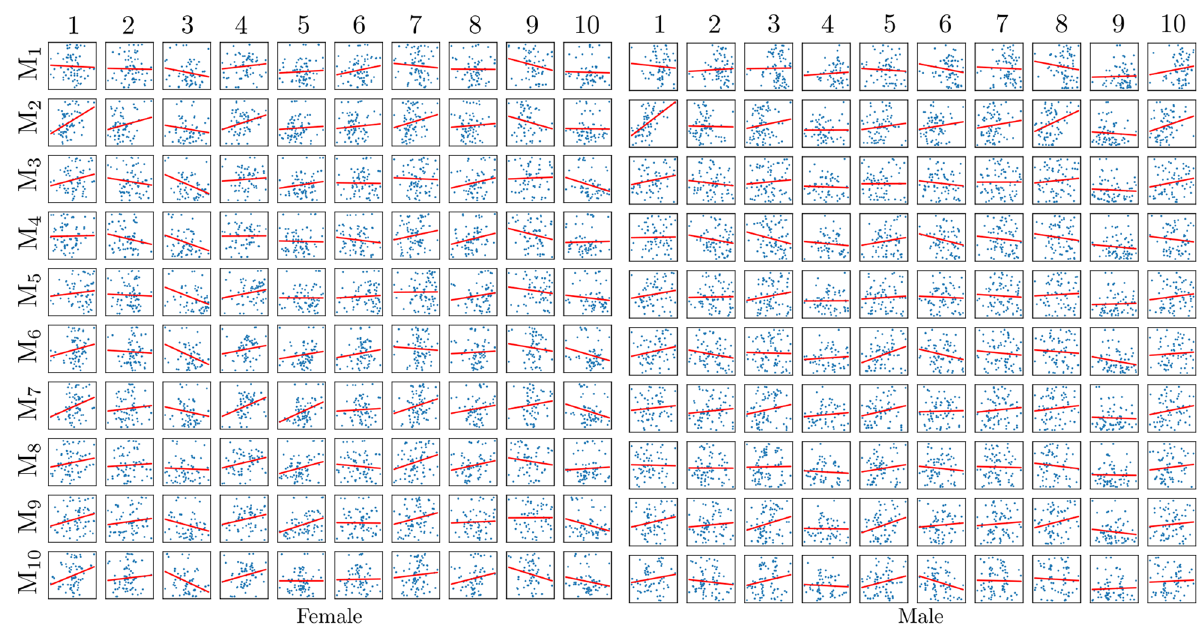
Figure 5. Relation of anthropometric distances and modal stiffnesses computed with model FEMP-II. Blue points represent raw data, while the red curve is regression line fitted.